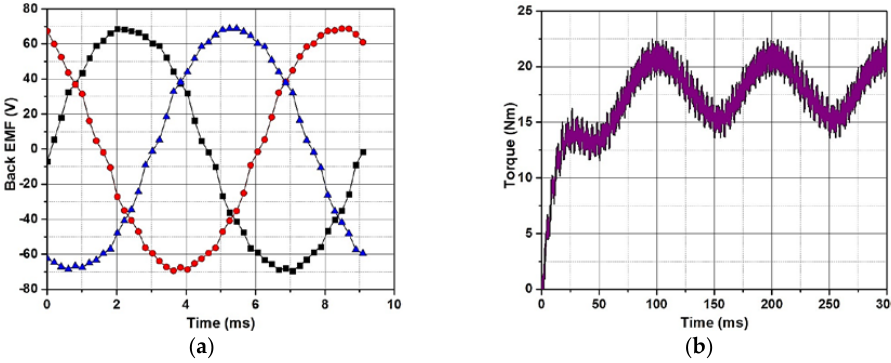
Figure 5. ( a ) Induced back EMF for 5 A DC field current at 300 rpm and ( b ) electromagnetic torque.